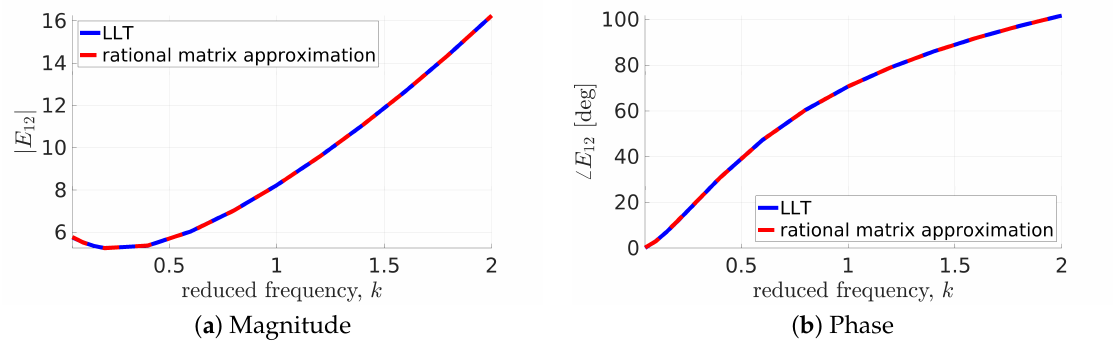
Figure 14. Comparison between computed and approximated transfer function E 12 ( k ) .